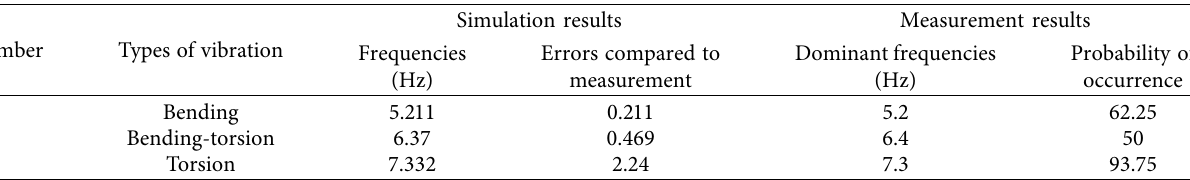
Table 6: Results of frequencies, vibration types, comparison, and probability of occurrence (obtained from LAM).